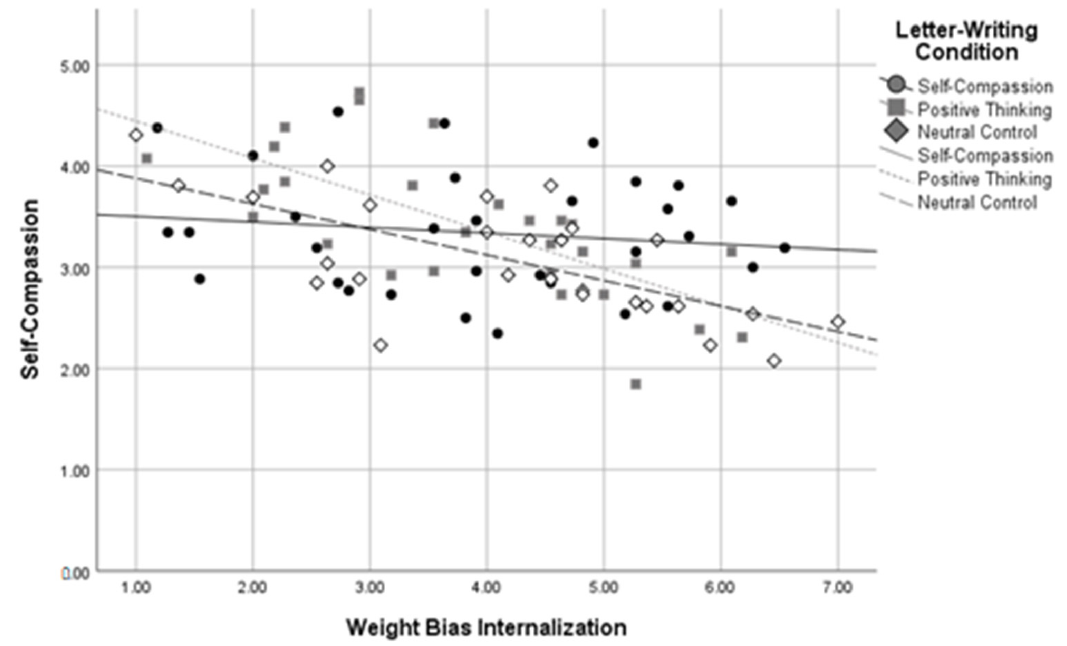
Figure 5. Letter-Writing Condition*Weight Bias Internalization Interaction on Self-Compassion.